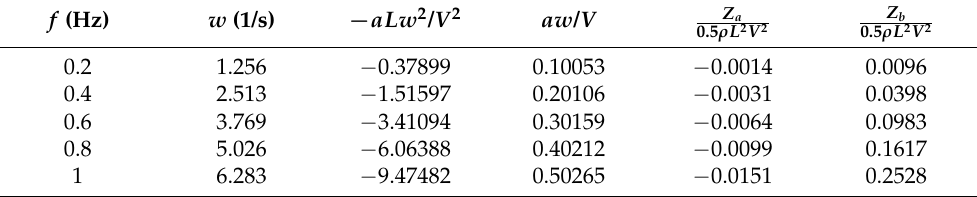
Table 11. Numerical results of pure heave motion of the standard ellipsoid by our CFD method.